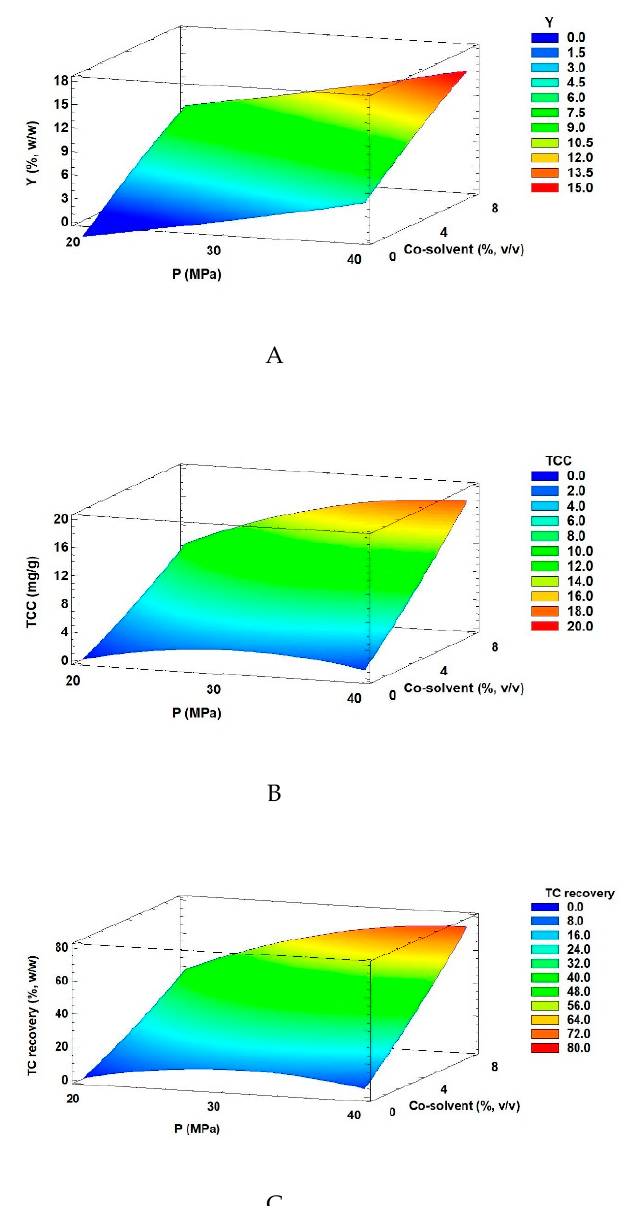
Figure 3. Response surface plot showing combined effects of pressure and co-solvent on (A) extraction yield (Y), (B ) total carotenoids content (TCC), and (C) recovery (TC recovery) from I. galbana . All extractions were done at 60 °C temperature.